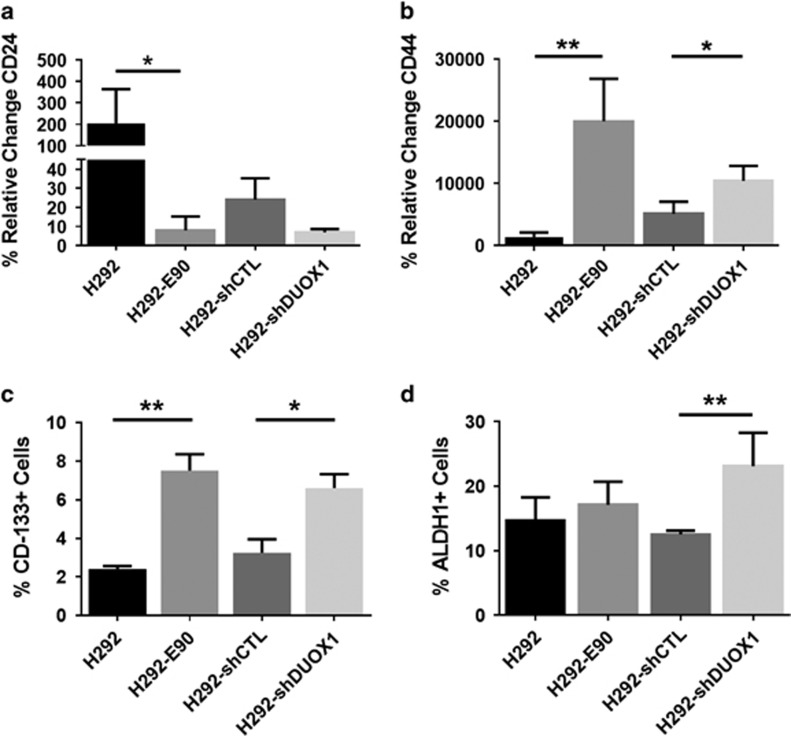
DUOX1 silencing enhances proportions of EMT-like CD24low/CD44high cell populations and elevates expression of CSC markers CD-133 and ALDH1. (a, b) FACS results of relative percent change of surface antigen CD24 and CD44 (left/right, respectively) vs their unstained controls. (c) FACS results of %CD-133+ cells as compared with their individual controls. (d) FACS results of %ALDH1+ cells as compared with their controls. *P<0.05 and **P<0.01 were calculated by Student's t-test.